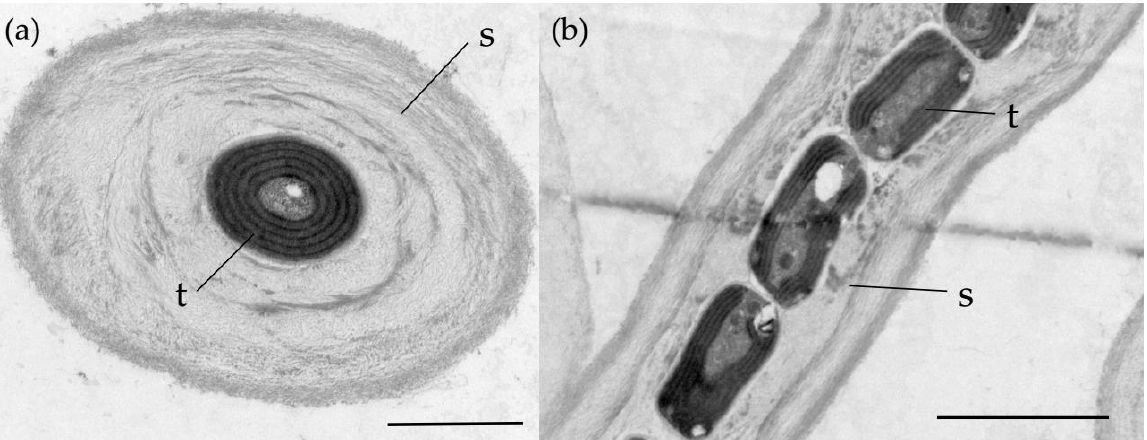
Figure 3. TEM micrographs of Nodosilinea hunanesis . ( a ) Cross-section of a cell within its surrounding 175 sheath. ( b ) Longitudinal section of a filament. Scale bar: ( a ) =1 μm, ( b ) = 2 μm . s, sheath; t, thylakoids. 176 Thylakoids are arranged more or less parallel in a parietal position. 177